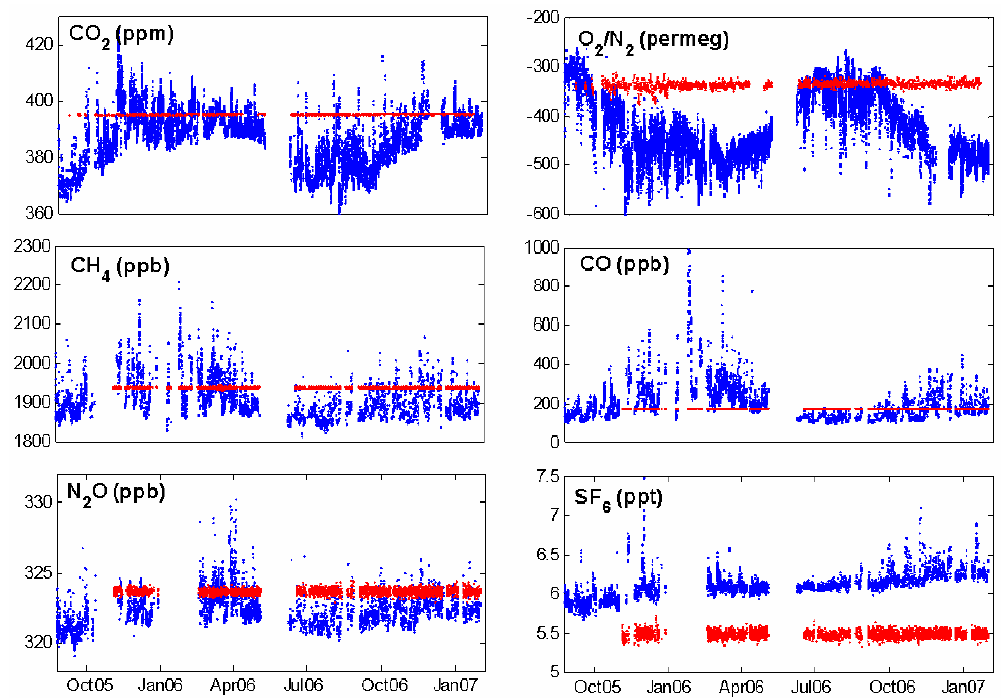
Fig. 4. Comparison between the noise of the Target gas measurement (red) and the atmospheric variability at 300m above ground (blue). In order to use the same y-scale for both air and Target gas results, the values of O 2 /N 2 Target gas measurement have been adjusted with − 200per meg and the values of SF − 6 Target gas measurement with